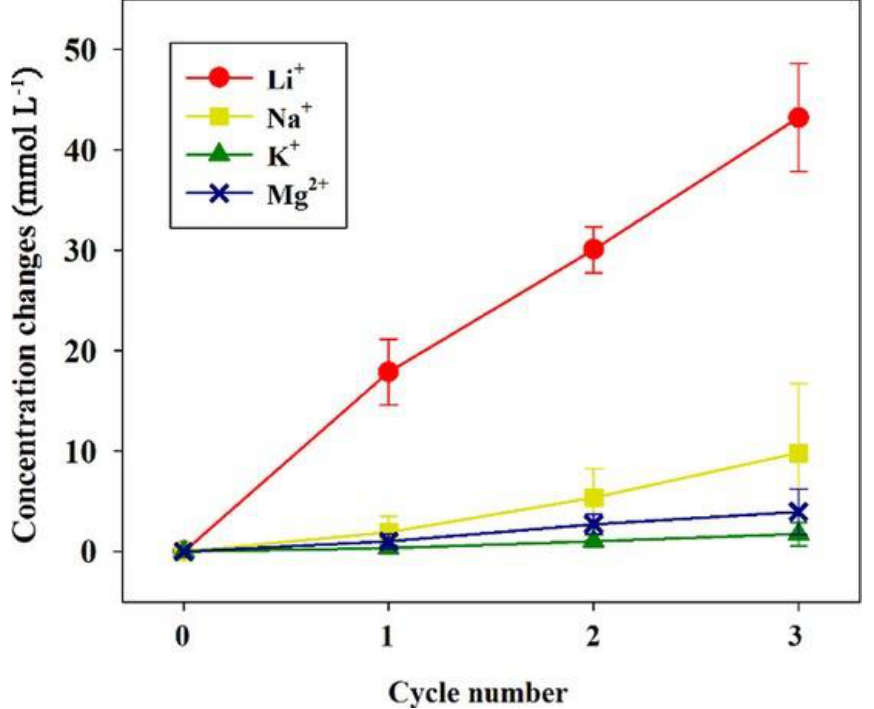
Figure 12. Selective lithium recovery with the LMO-Zn system in the presence of other cations (Na + , K + , and Mg 2+ ): the concentration changes in the charging solution during 3 cycles. Reprinted with permission from Ref. [77]. Copyright 2019 Wiley.